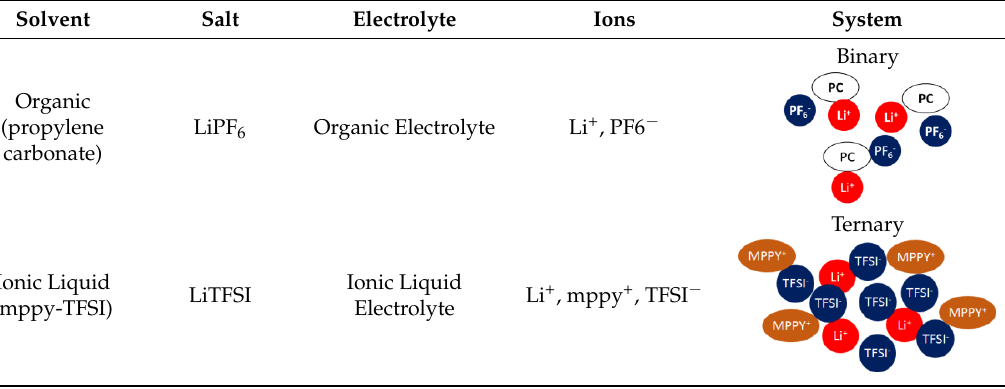
Table 1. Comparison between organic-liquid-based binary electrolyte and ionic-liquid-based ternary system. Adapted with copyright permission from Yoo et al. [39], with permission from Elsevier.